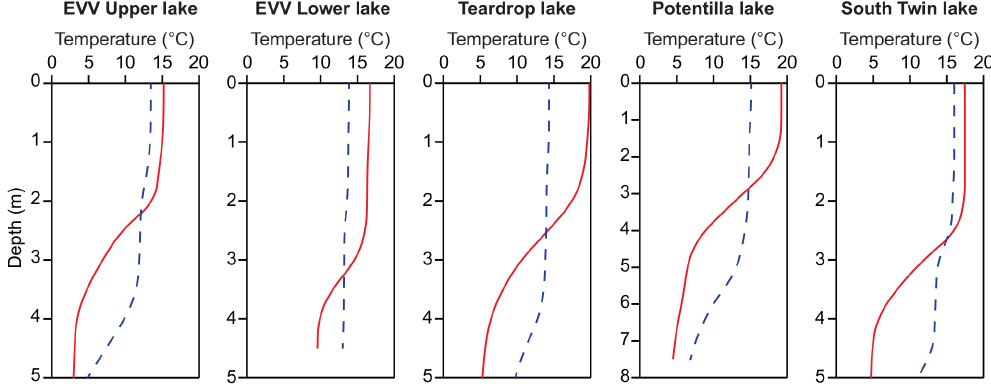
Figure 4. Profiles of temperature under open-water conditions in 2012 (red solid line) and 2013 (blue dashed line).